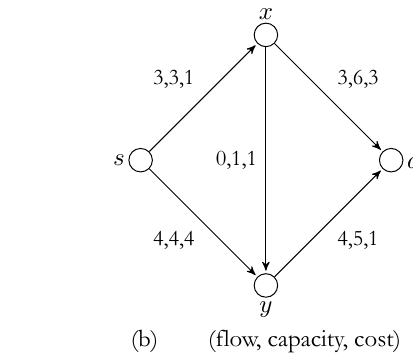
Figure 1: (a) Existing evacuation network (b) Maximum static flow solution with time as cost on arcs.